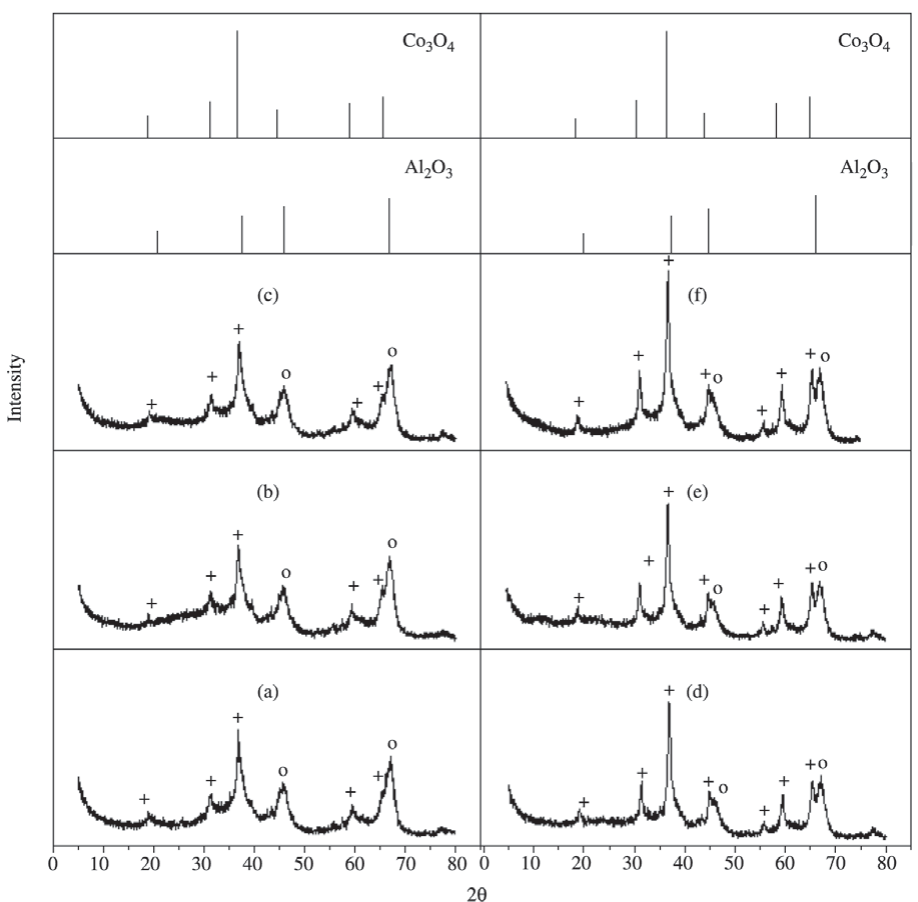
Figure 2. Diffractograms of the catalysts: a) 5Co; b) 0.5Ag/5Co; c) 1Ag/5Co; d) 9Co; e) 0.5Ag/9Co; f) 1Ag/9Co. (+) Co